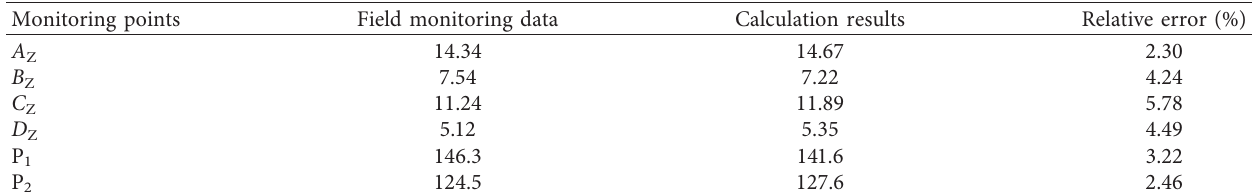
Table 5: Comparison between the calculation results and the field monitoring